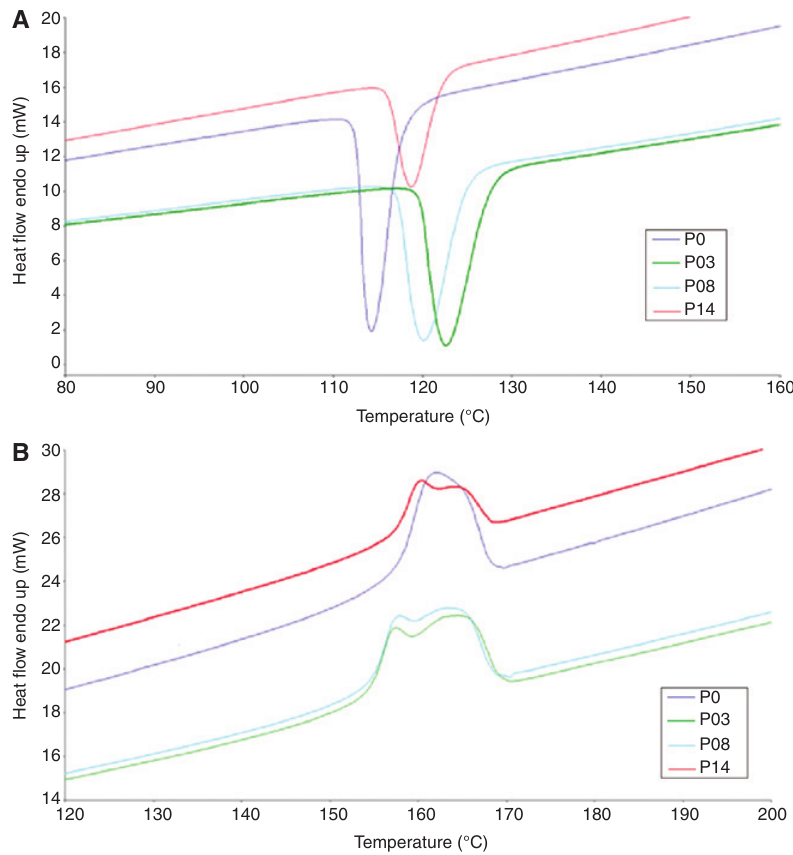
Figure 2: (A) Exothermic (crystallization) and (B) endothermic (melting) peaks of the polypropylene